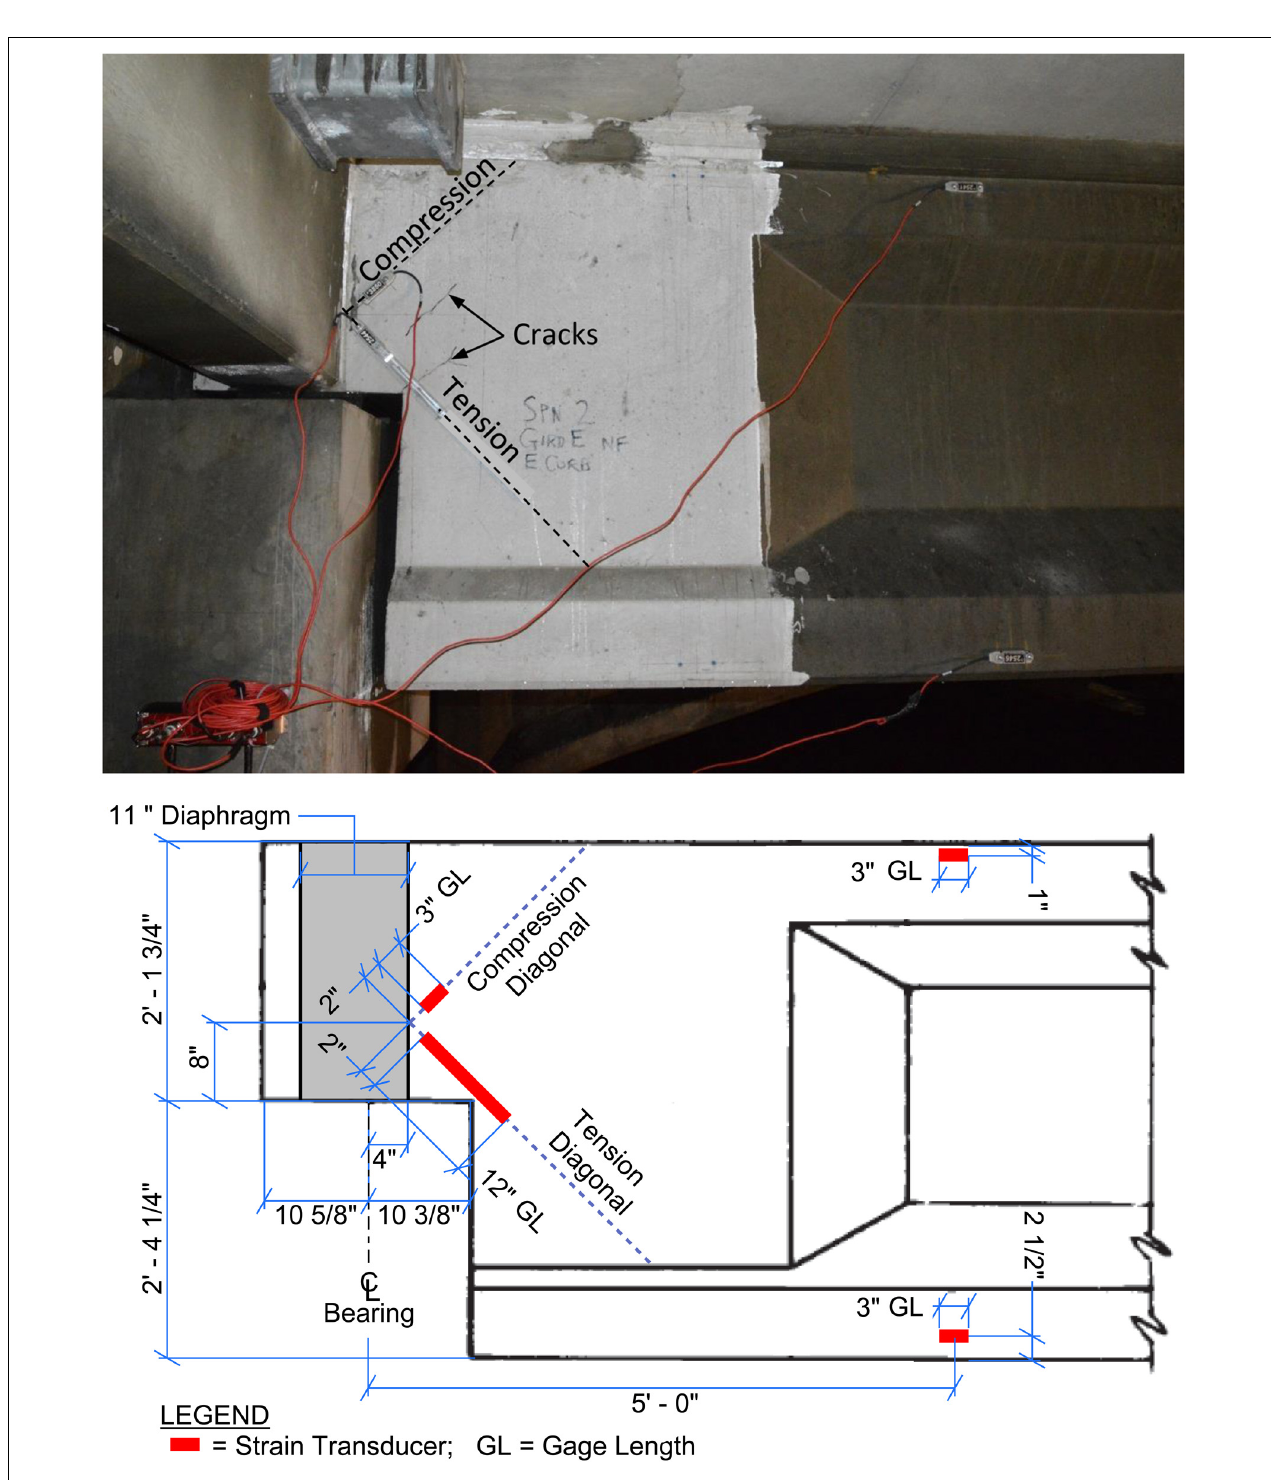
FIGURE 5 | Strain transducers on concrete surface at dapped end.